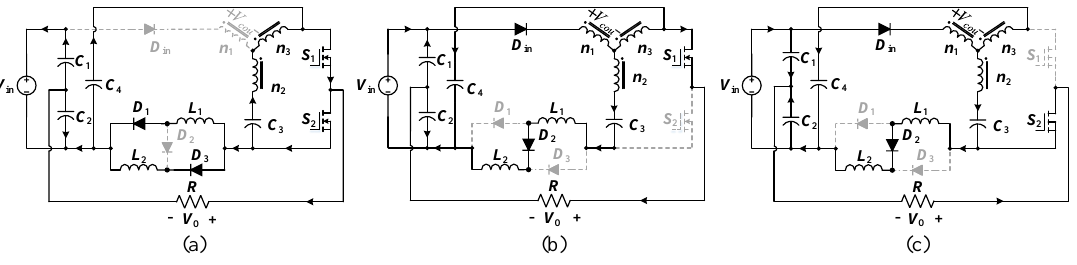
Figure 3. Equivalent circuits in ( a ) Mode 1: S 1 and S 2 are on; ( b ) Mode 2: S 1 is on and S 2 is